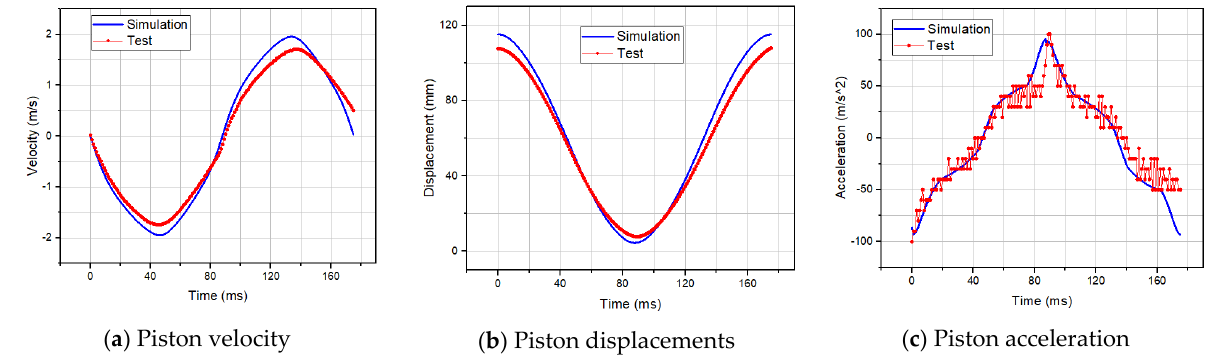
Figure 8. Comparison of the test result and simulation result.